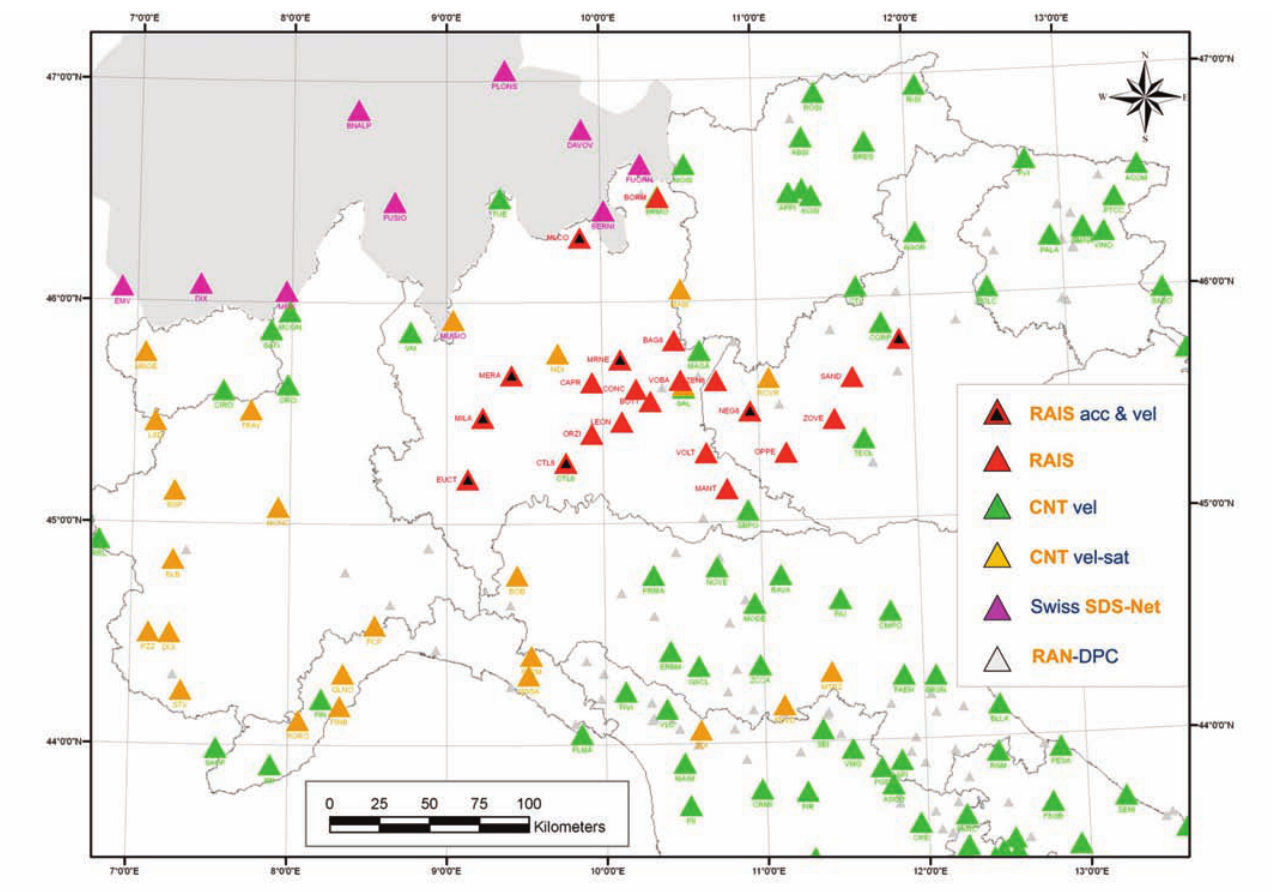
Figure 3. RAIS and national seismic networks in northern Italy and its surroundings. Red triangles, RAIS stations (http://rais.mi.ingv.it); black triangles inside red triangles, site equipped with both weak and strong-motion sensors; green triangles, velocimetric stations managed by the National Earthquake Center of INGV (CNT, http://cnt.rm.ingv.it/); yellow triangles, INGV-CNT satellite velocimetric stations; gray triangles, RAN strong-motion stations managed by Italian Civil Protection (DPC, http://www.protezionecivile.it/); violet triangles, SDS-Net velocimetric stations